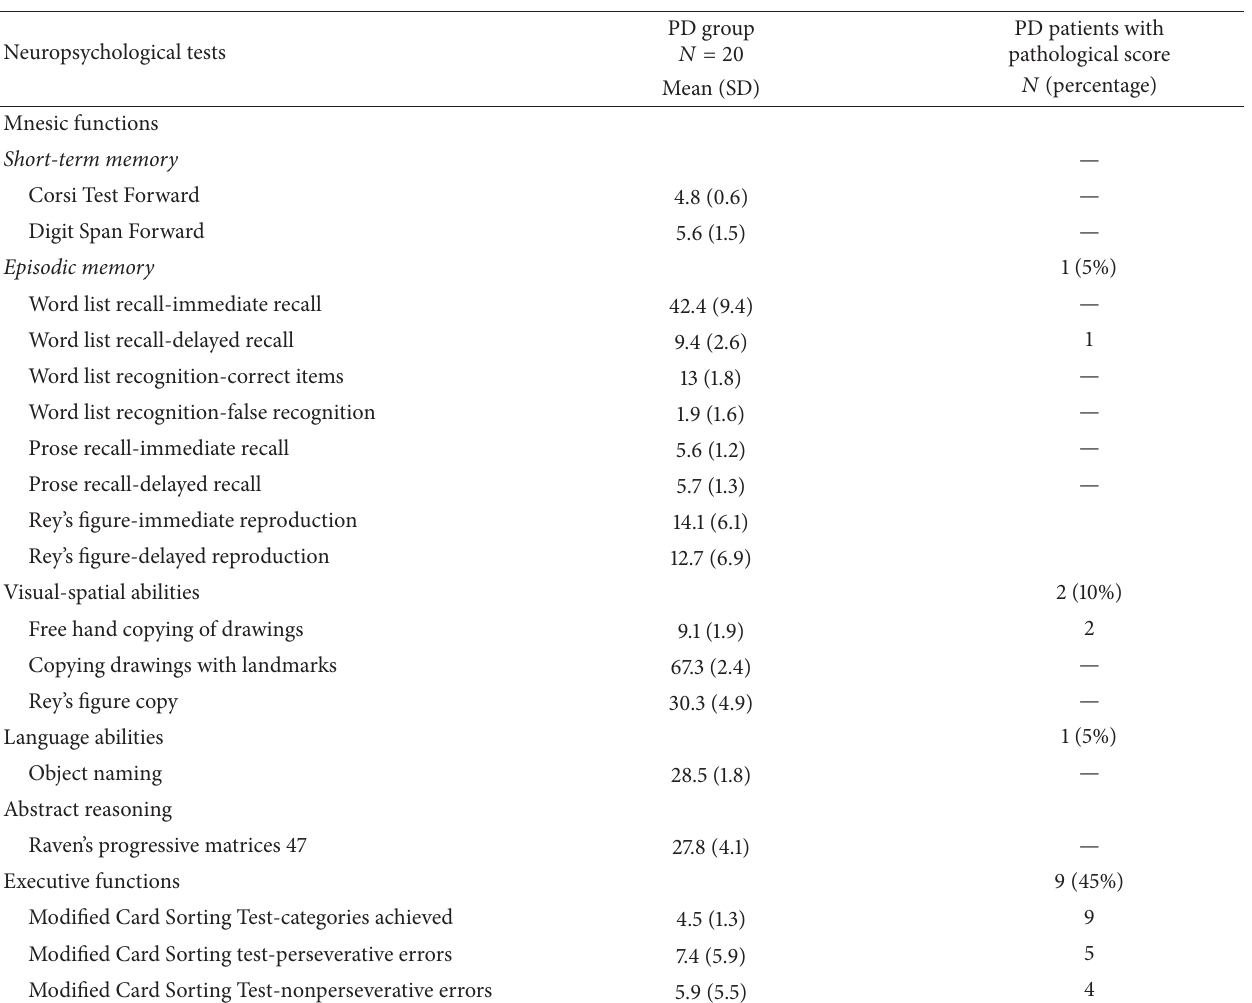
Table 2: PD patients’ performance (average scores and percentage of pathological values) on the test of the neuropsychological battery. For all tests, with the exception of Modified Card Sorting test-perseverative and nonperseverative errors, higher scores mean better